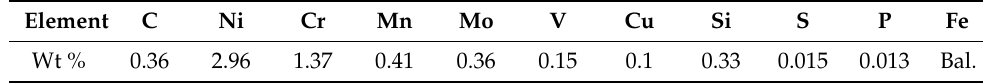
Table 3. Chemical composition of rotor steel